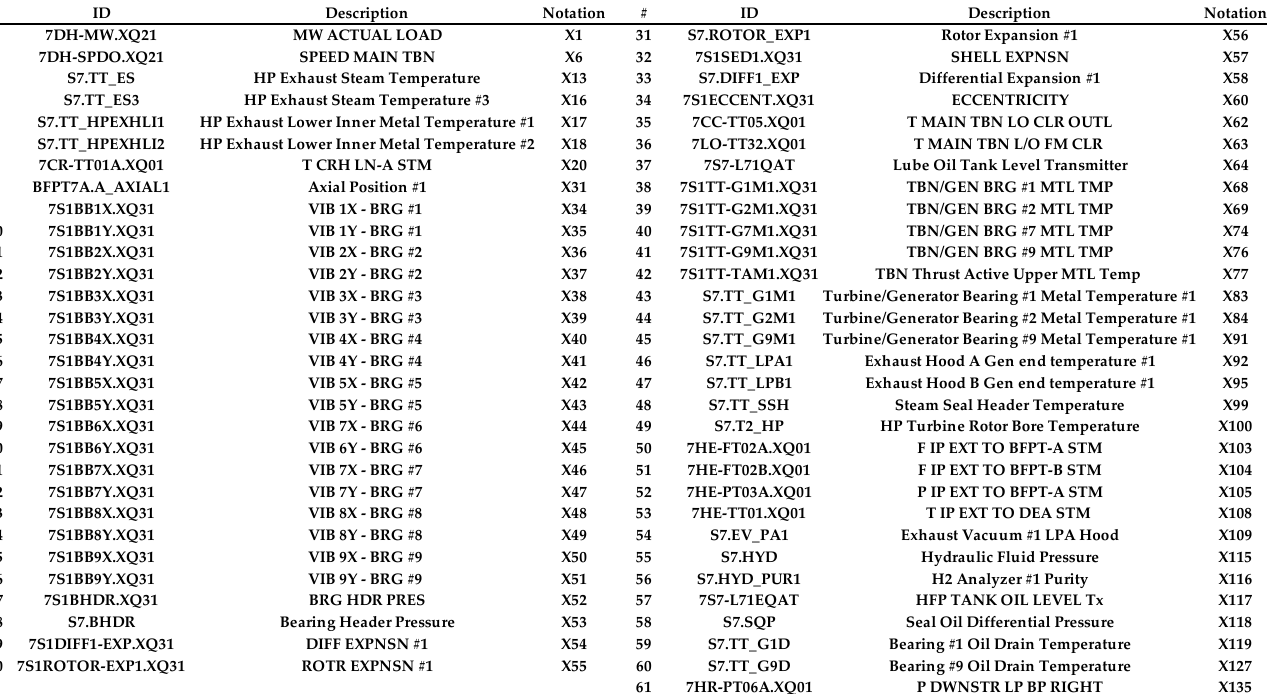
Figure 16. List of the optimal sensors selected by correlation analysis. The mRMR algorithm is applied to the sensor data to minimize the redundancy while keeping the relevance. Figure 17 shows the sensor rank with the predictor importance score. X25 with tag id P1HAH77CT005XQ01 representing the SH III metal temperature is on the 1st rank with a predictor importance score of 0.22, followed by X1 (generator active power). Figure 9b shows the 21 optimal sensors that are selected.